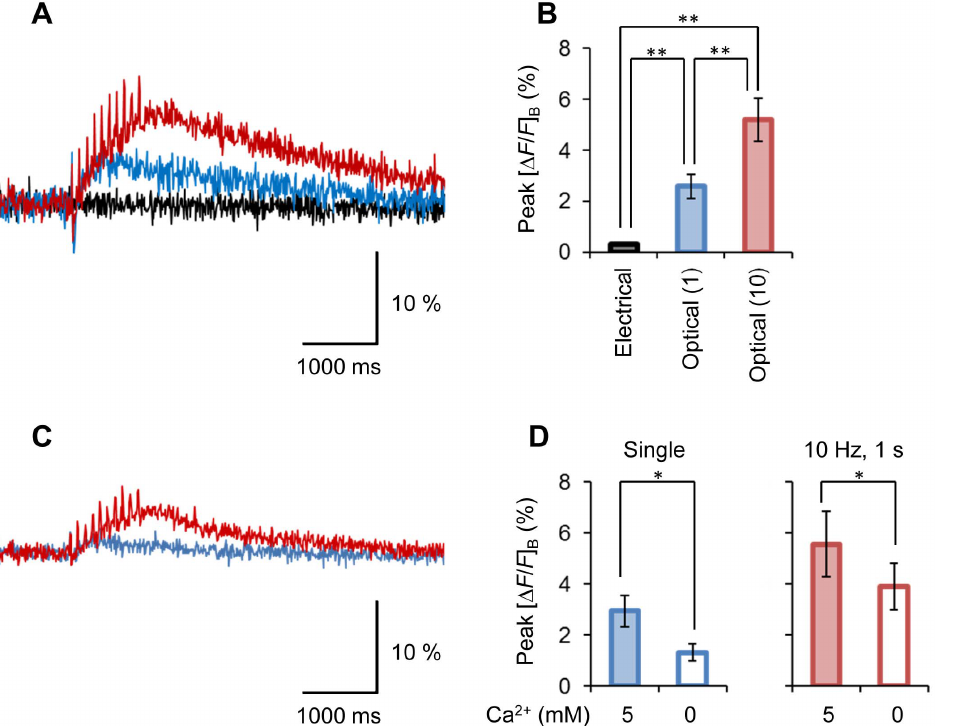
Figure 6. Optogenetic Ca 2 + mobilization. A , Typical [ D F/F ] B changes in the TTX-treated presynaptic terminal: the response to a single 20 ms laser pulse (blue), the response to a train of laser pulses (10 Hz) for 1 s (red) and the response to electrical stimulation (10 Hz, 1 s) to the oculomotor nerve (black). Each trace is an average of five consecutive records. B , Summary of peak [ D F/F ] B changes (mean 6 SEM) in the presence of TTX. Each column indicates (from left to right) the response to the train of electrical stimulations (10 Hz, 1 s), the single optical stimulation and the train of optical stimulations (10 Hz, 1 s). **, P , 0.01 (n=8). C , Sample [ D F/F ] B responses of the same presynaptic terminal as shown in A , but with the extracellular Ca 2 + being removed (EGTA, 1 mM). Each trace is an average of five consecutive records. D , The dependence of TTX-resistant [ D F/F ] B changes (mean 6 SEM) on the extracellular Ca 2 + of 5 mM (left) and 0 mM (right): the response to single optical stimulation (left) and the response to a train of electrical stimulations (10 Hz, 1 s) (right). *P , 0.05, two-tailed t -test